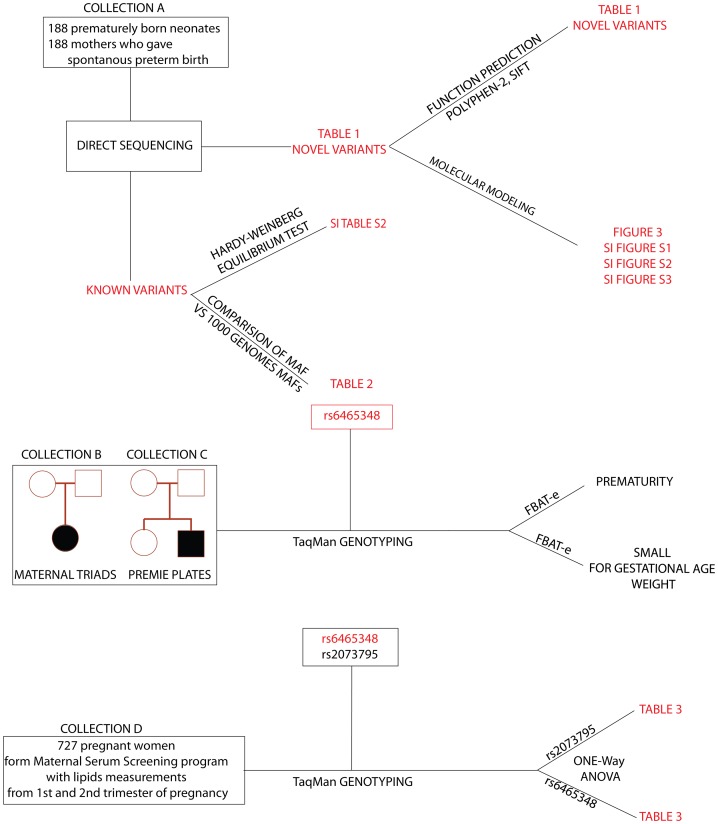
Experimental design and workflow.Panels show CYP51A1 analysis workflow by direct sequencing (searching for novel functional variants) and the analysis on population level by genotyping of commonCYP51A1 variants and family based studies.